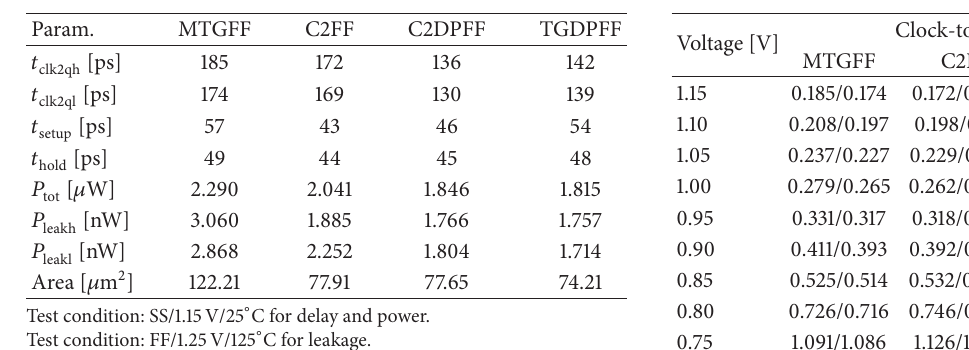
Table 2: Delay sensitivity over 𝑉